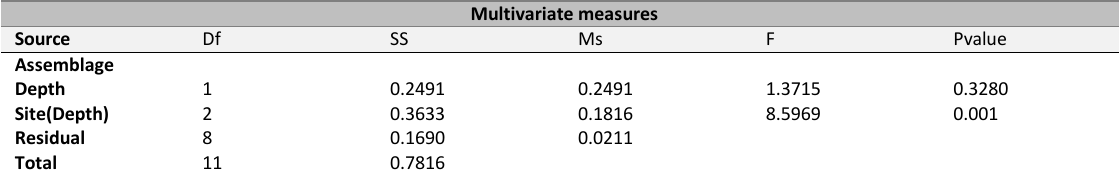
Table 4: Results of multivariate NP-Manova testing the interactive effects of the depth (of deployment) and site (nested in depth) on the presence/absence assemblage. Sites tested: (AGD2 vs